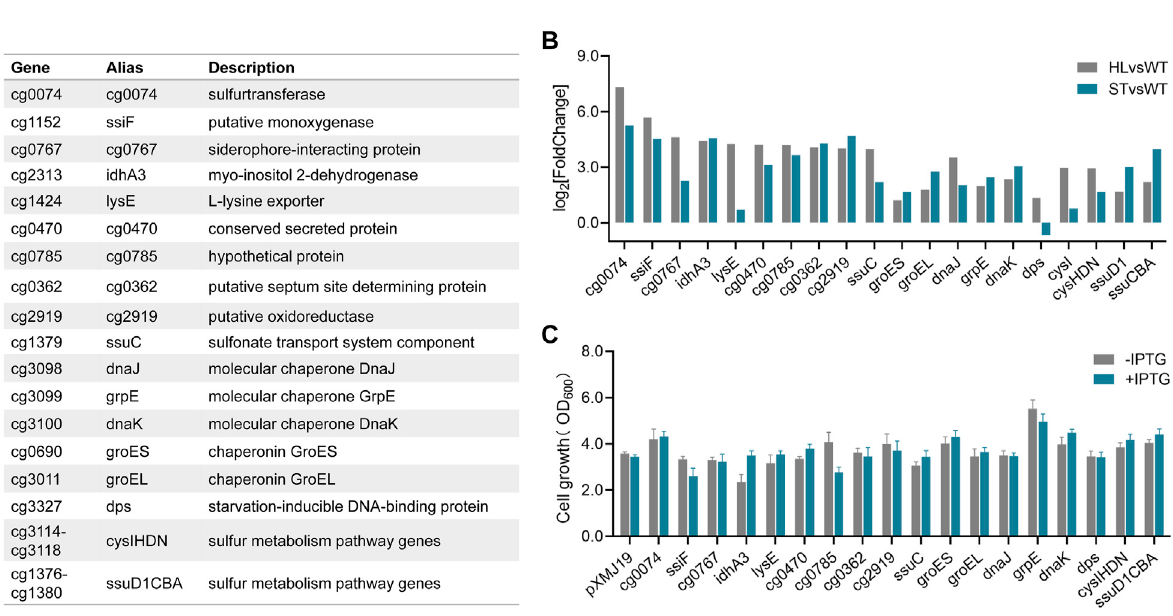
FIGURE 4 Effects of some representative DEGs on conferring high-lysine tolerance. (A) A summary of 18 differentially expressed high-lysine-related genes. (B) Relative expression levels of 18 DEGs in selected samples based on RNA-seq data. (C) Cell growth of C. glutamicum recombinant strains containing the control plasmid pXMJ19 or its derivatives under stressful conditions with or without IPTG addition. Then, 160 g/L lysine was used to mimic osmotic stress that occurs during the fermentation